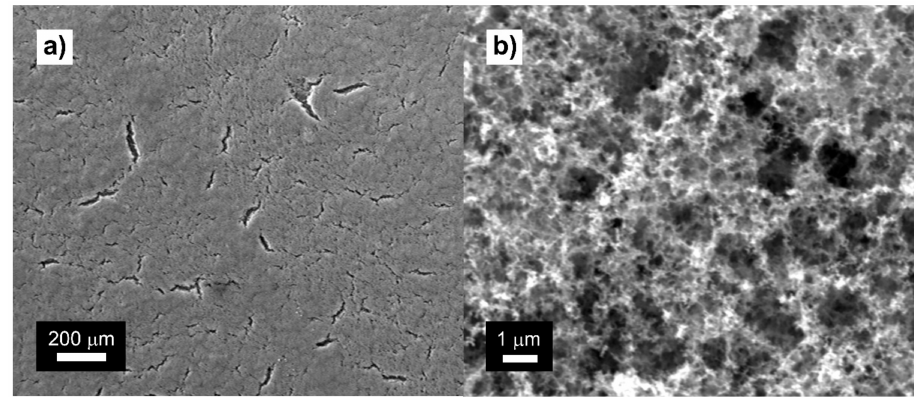
Figure 2. SEM micrographs of the 4 × CB6–PEG7–ATO coatings: ( a ) an image of the coating on the sub-millimeter scale; and ( b ) a higher magnification image showing the hierarchal meso-macroporous